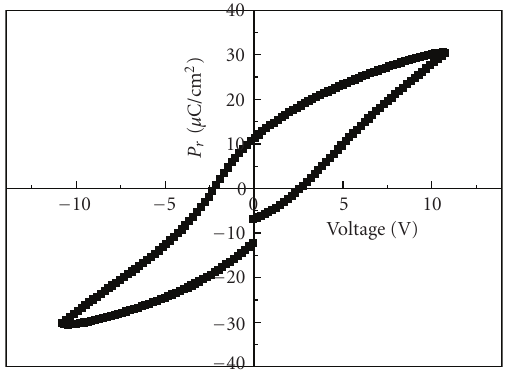
Figure 6: P-V hysteresis loop for CBTi144 thin film deposited on (100) Pt/Ti/SiO 2 /Si substrate at 700 ◦ C for 2 hours.